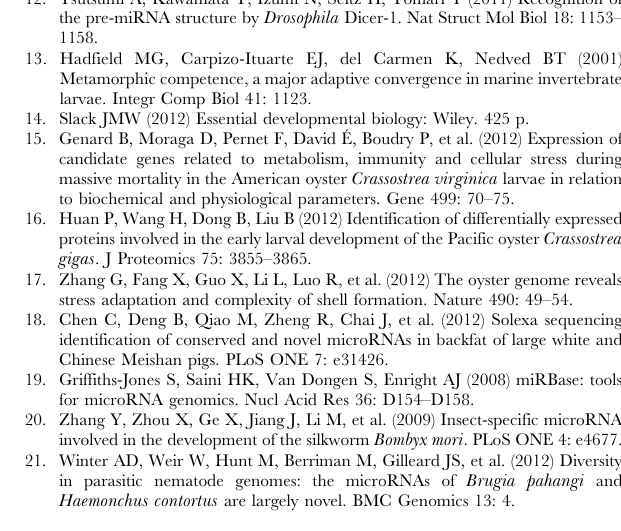
Table S5 Details of the 19 predicted novel oyster precursors and their mature miRNA products. This table shows the following information for the 19 predicted novel oyster precursors and their mature miRNAs: precursor ID; mature miRNA ID; the predicted free energy of folding; sequence and secondary structure of the hairpin precursor; sequence of the predicted mature miRNA; physical location of the hairpin precursor based on the oyster genome version 1 (scaffold ID, start site, end site, and strand); miRNA cluster information (a cluster was defined as having a maximum gap of 10 Kbp between contiguous precursors); miRNA age and phylostratum (evolution- ary acquisition, see the main text); the gene ID that overlapped with the miRNA and the strand information; read number and the RPM value for each miRNA in each sample. Table S6 The family distribution of conserved oyster miRNAs. Table S7 Details of the 27 potential oyster precursors and their mature miRNA products. This table shows the following information for the 27 potential oyster precursors and their mature miRNAs: precursor ID; mature miRNA ID; the reason excluding the corresponding precursor from oyster miRNA gene set; the predicted free energy of folding; sequence and secondary structure of the hairpin precursor; sequence of the predicted mature miRNA; physical location of the hairpin precursor based on the oyster genome version 1 (scaffold ID, start site, end site, and strand); miRNA cluster information (a cluster was defined as having a maximum gap of 10 Kbp between contiguous precursors); the gene ID that overlapped with the miRNA and the strand information; read number and the RPM value for each miRNA in each sample. Table S8 The BLAST hits of mir-184 in the oyster genome.